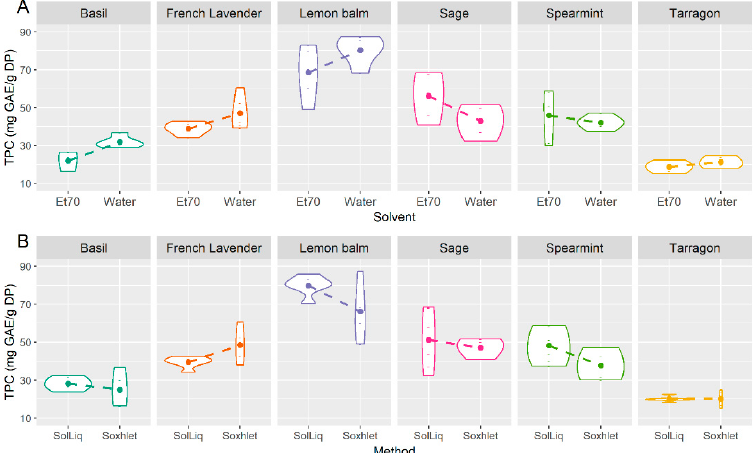
Figure 3. Interaction plots “plant × solvent” ( A ) and “plant × method” ( B ) on the total phenolic content of plant extracts.